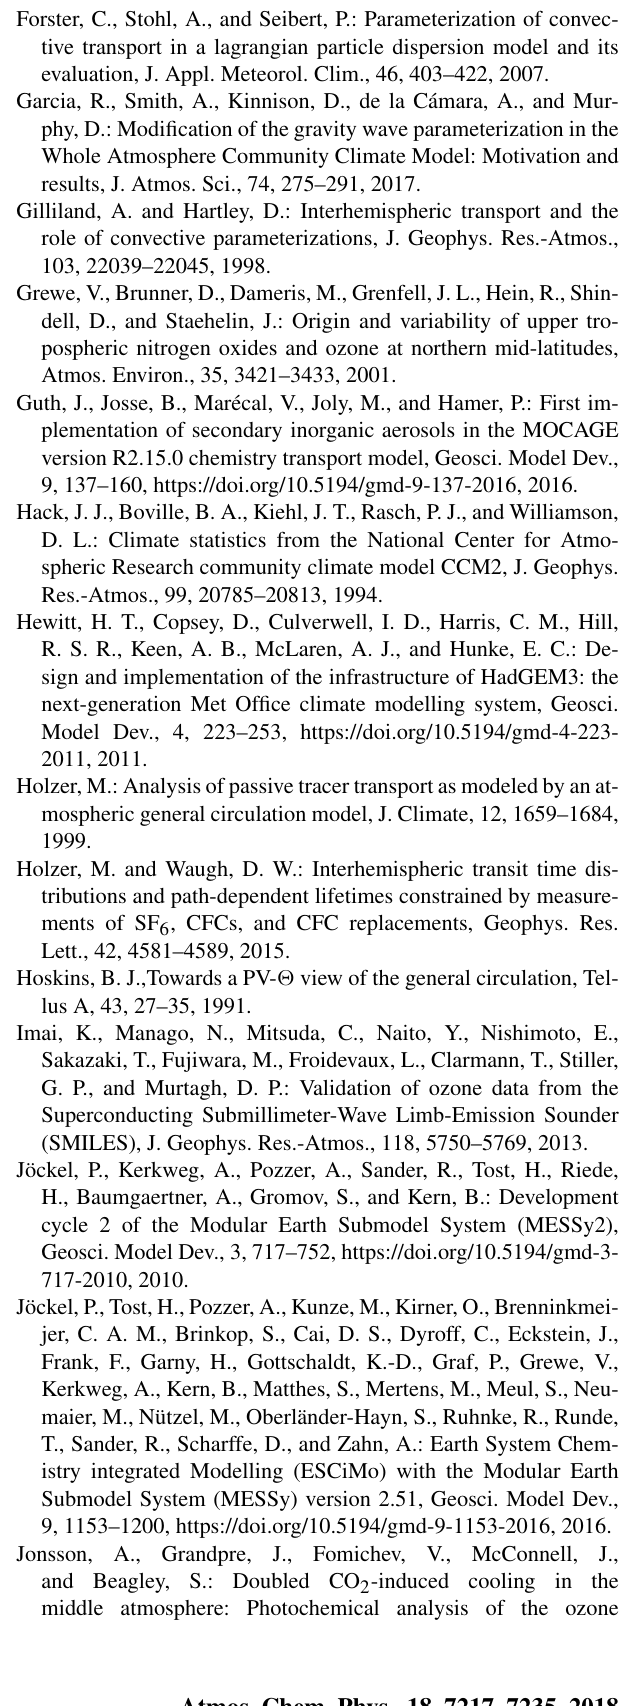
National Computational Merit Allocation Scheme (q90) and the Australian Antarctic science grant program (FoRCES